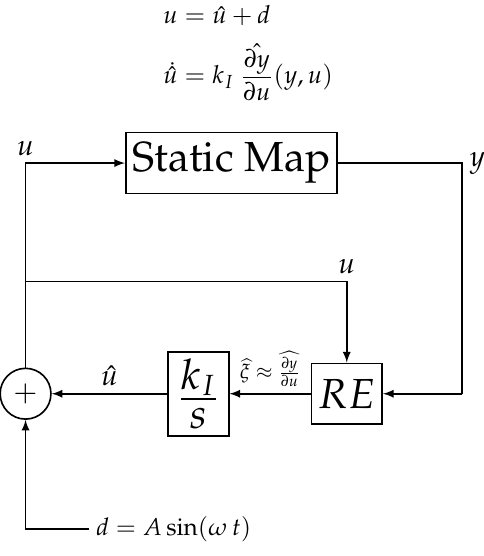
Figure 3. Extremum seeking with a recursive